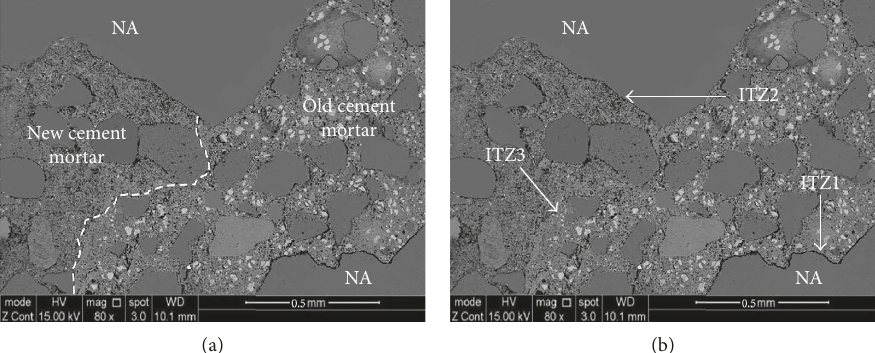
Figure 12: (a) SEM image of a concrete sample with nanosilica; (b) image of the ITZs of a concrete sample with nanosilica.